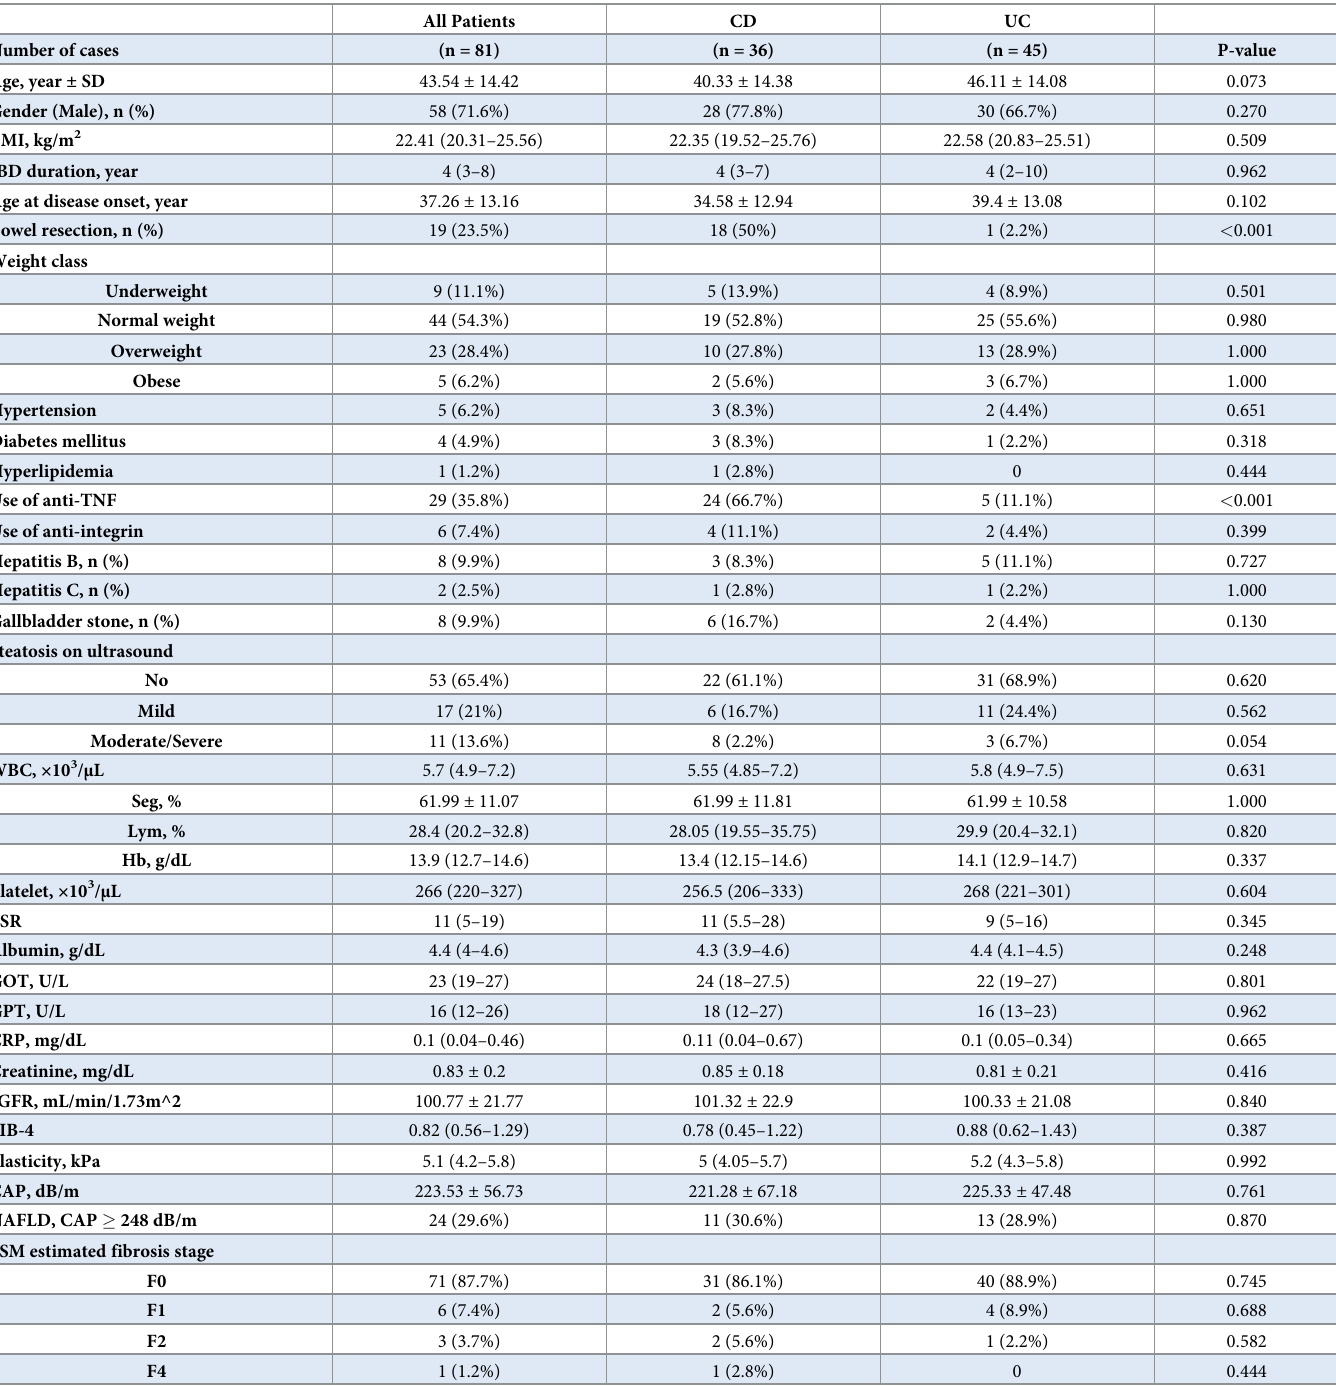
Table 1. Patient baseline